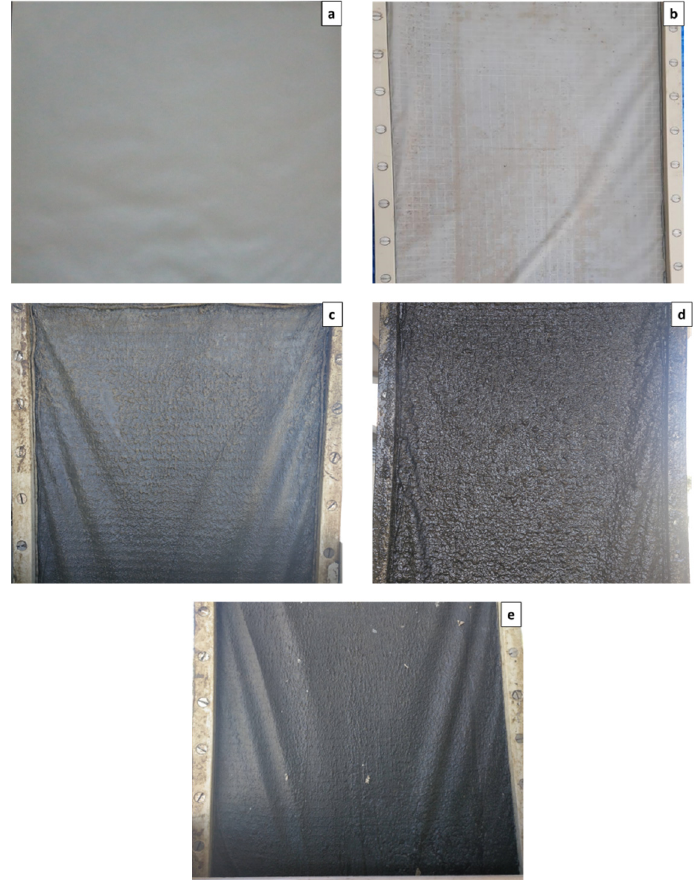
Figure 3. Pilot-plant supporting material after every experimental period: ( a ) New, ( b ) Exp. 1, ( c ) Exp. 2, ( d ) Exp. 3 and ( e ) Exp. 4.